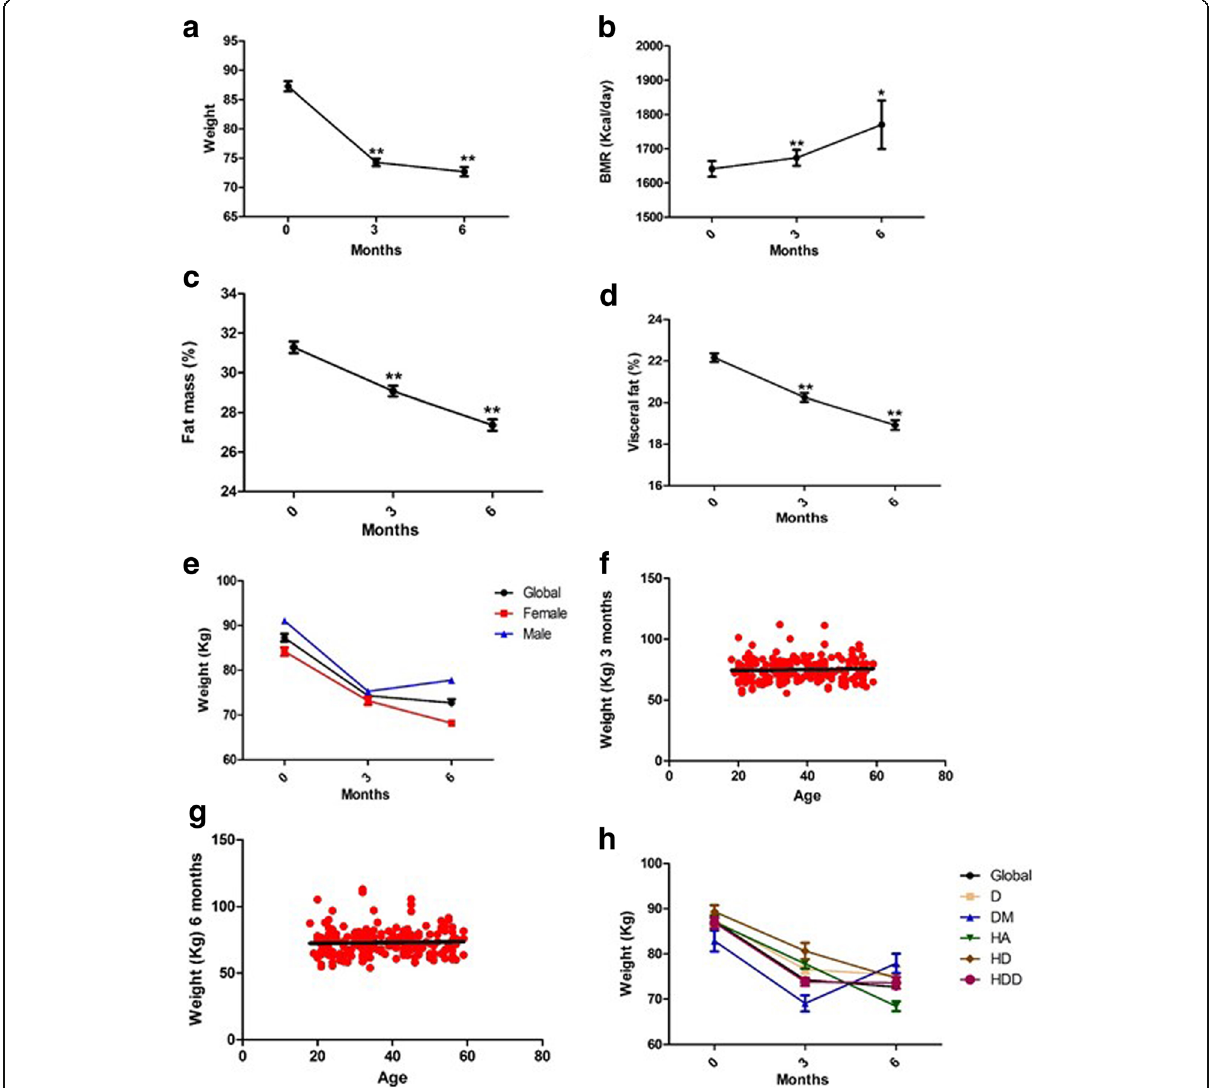
Fig. 1 Effects of GC and GNN on body composition. Weight ( a ), Basal metabolic rate ( b ), Fat mass ( c ), Visceral Fat ( d ) and influence of sex ( e ), age − 3 months ( f ) and 6 months ( g )- and presence of comorbidities ( h ) in weight reduction. D: Dyslipidemias, DM: Diabetes mellitus type 2, H: Hypertension, HD: Hypertension and Dyslipidemias, HDD: hypertension, dyslipidemias and DM2. * p < 0.05;** p < 0.01 vs treatment onset (0